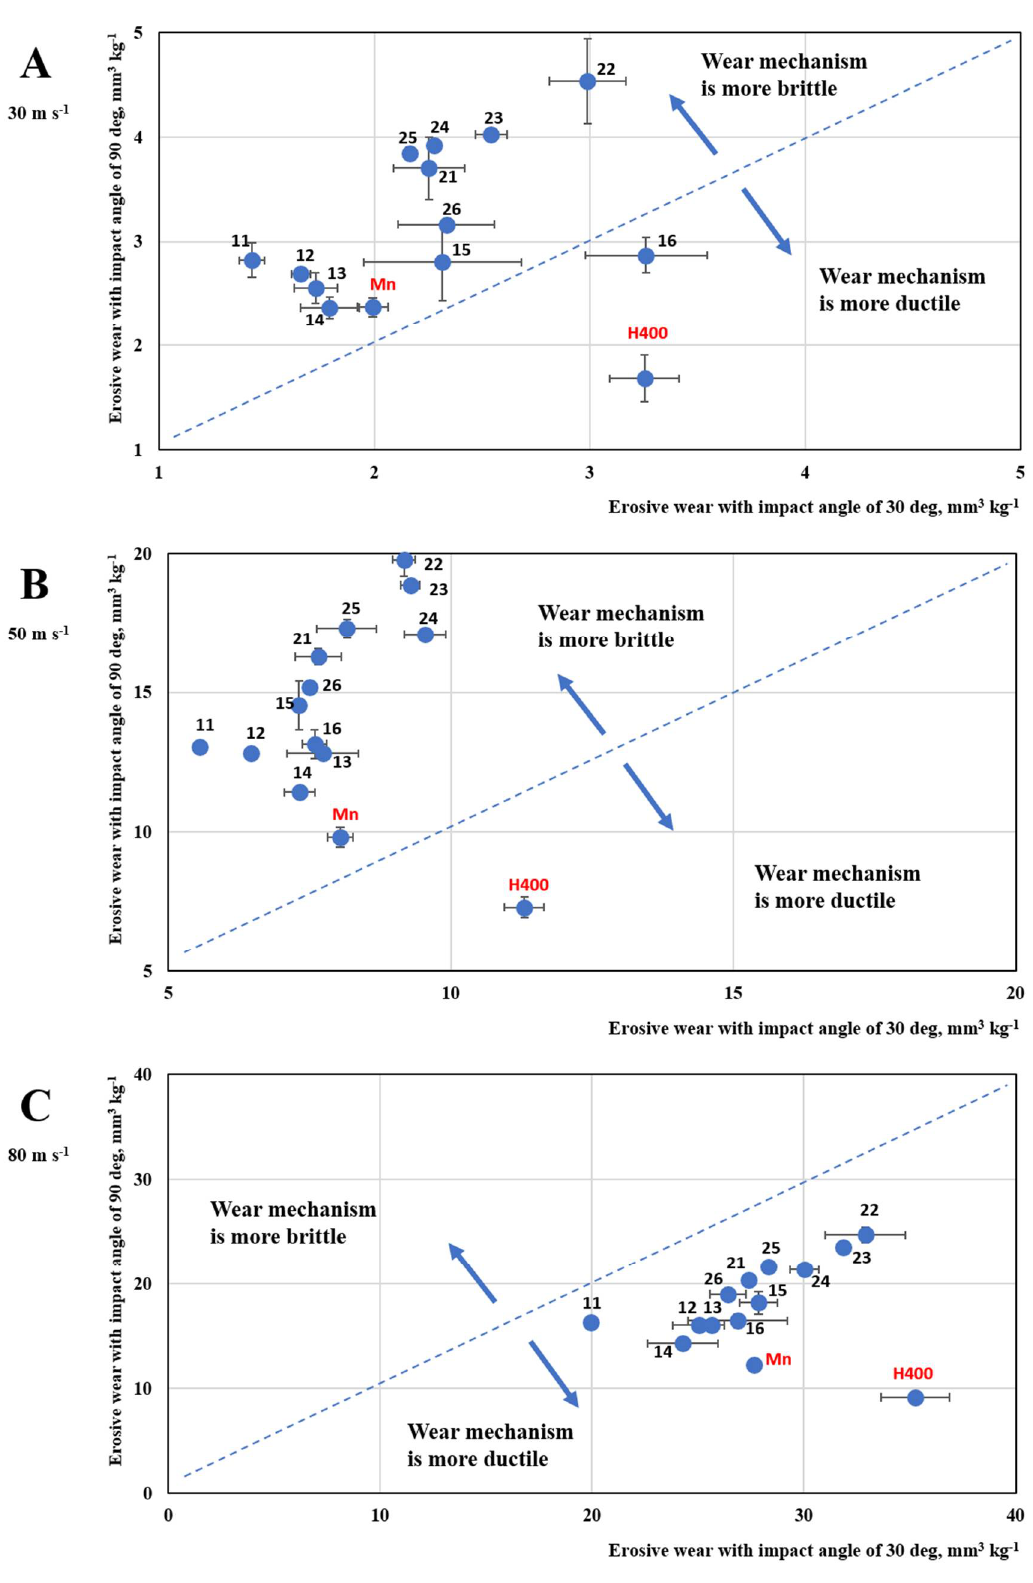
Figure 15. Evaluation of the hardfacings’ erosive wear mechanism acting at various impact velocities (wear rates measured with impact angle of 30° and 90° at room temperature).